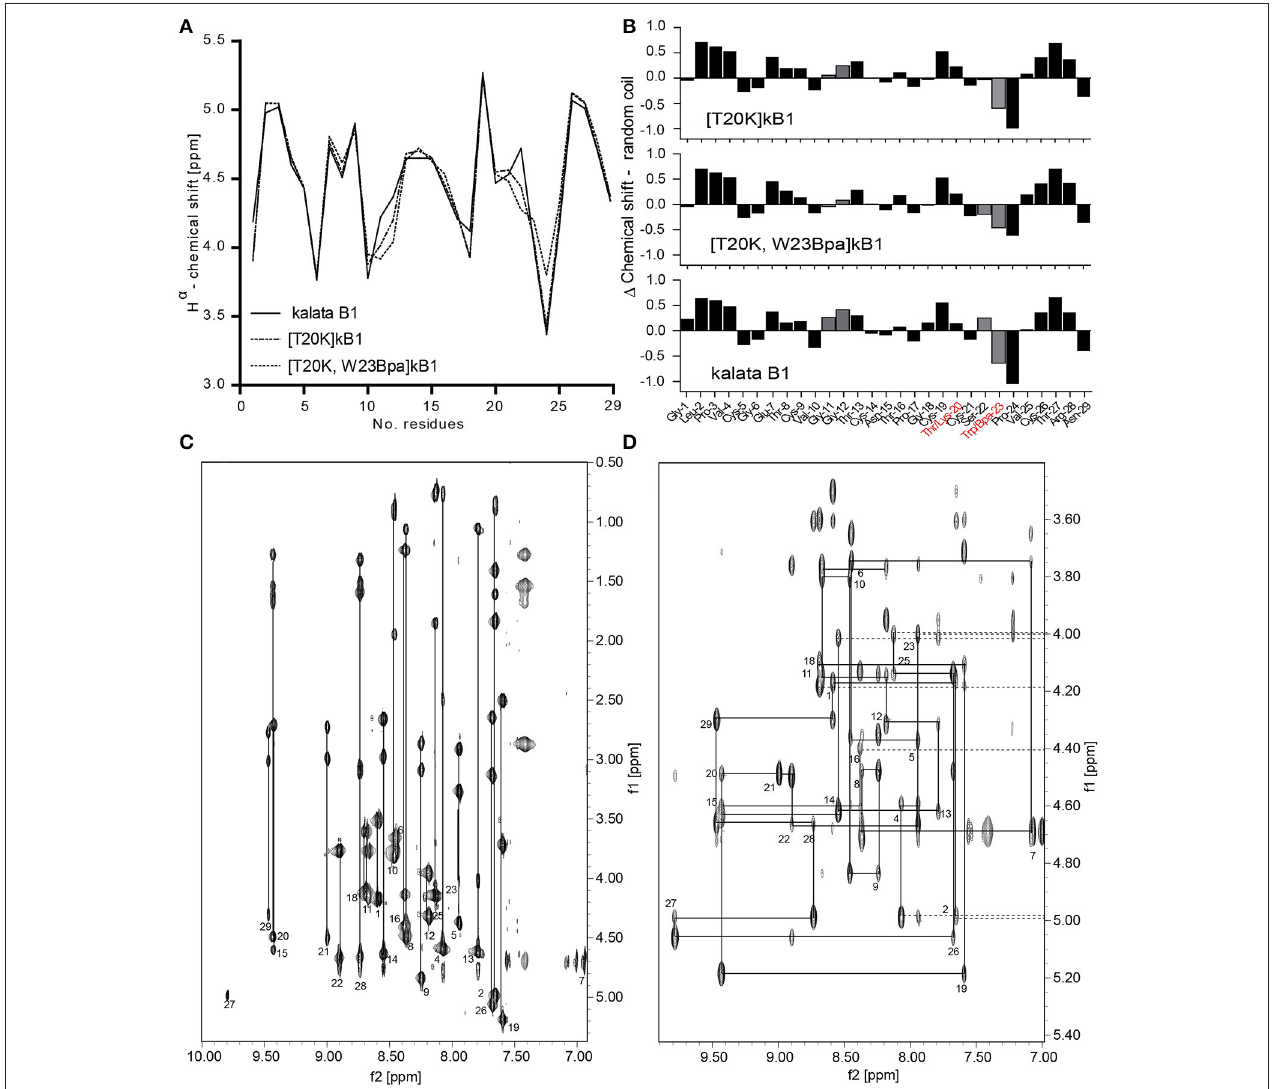
FIGURE 2 | Structural integrity of the circular peptide probe. (A) Superimposed H α -chemical shifts of kalata B1 (kB1), [T20K]kB1, and [T20K,W23Bpa]kB1 are shown. (B) Secondary structure elucidation of the cyclotide probe [T20K,W23Bpa]kB1 in comparison to endogenous kB1 and the reference mutant [T20K]kB1 as determined by examining H α -proton shifts relative to the random coil configuration. Delta ( 1 )-values (random coil—experimental values) are presented where numerical values ± 0.1 ppm suggest a well-defined structure. Mutations sites are highlighted in red characters. The recognized H-proton shifts for residues Gly 11 -Gly 12 and Ser 22 -Trp 23 are indicated with gray filled bars. (C) NH-H α fingerprint region of the TOCSY spectrum of [T20K]kB1 showing intraresidue connectivities. (D) Sequential d α N(i,i + 1) connectivities in the NH-H α fingerprint region of the NOESY spectrum for [T20K]kB1.